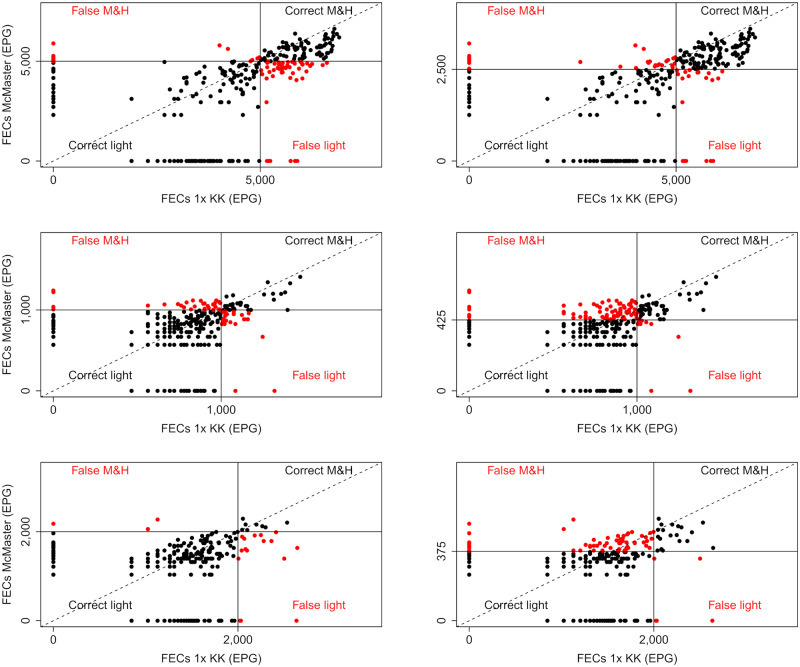
Agreement in classifying infection intensities for McMaster when applying WHO and method-specific thresholds.The scatter plots represent the degree of agreement between McMaster and a single Kato-Katz (1x KK; reference method) in classifying infection intensity based on either World Health Organization (WHO; Table 1) and method-specific thresholds (Table 4) for Ascaris, Trichuris and hookworms. The full black dots indicate that intensity of infection was correctly classified as light (bottom left quadrant) and moderate-to-heavy (M&H; top right quadrant). The red dots indicate that intensity of infection was falsely classified as light (bottom right quadrant) and M&H (top left quadrant). The full lines represent the thresholds, the dashed line represents the line of equality.